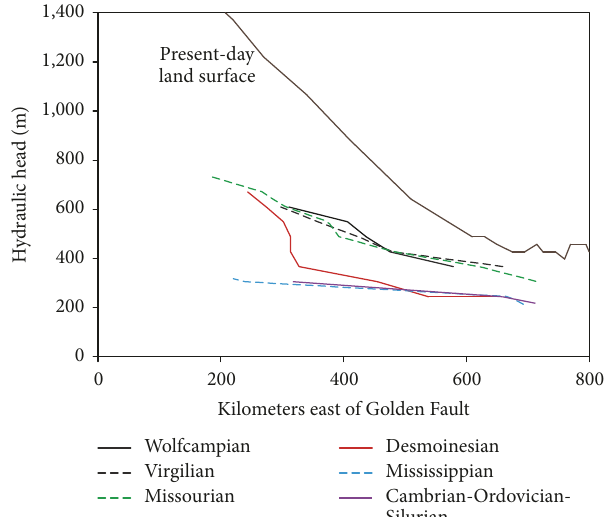
Figure 12: Hydraulic head versus distance digitized from head contours. Hydraulic head for six geohydrologic units along line A-A 󸀠 , which serve as control data for the hydrologic model of this paper. Head values were digitized from potentiometric maps such as those shown in Figures 9, 10, and